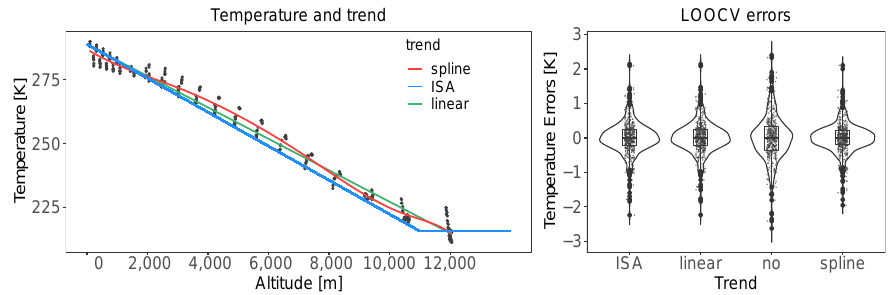
Figure 12. ( Left ) Scatterplot of temperature and three trend models: spline, linear regression, and ISA. ( Right ) LOOCV errors with four trend